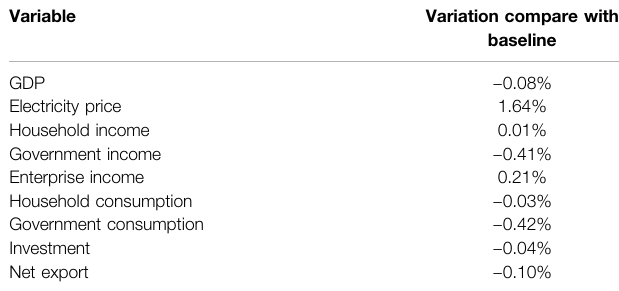
TABLE 3 | Impact on